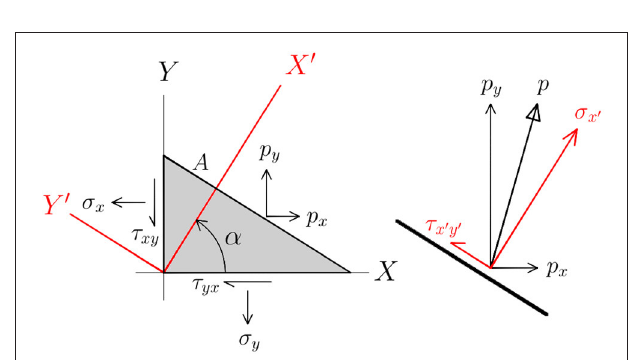
anti-clockwise torque T about the X -axis. In (A) the radial distribution of stress due exclusively to torque is shown along the Y - and Z -axes, in (B) the uniform stress due to the vertical force V is shown along the Y -axis, and in (C) the superposition of those stresses on the Y -axis is shown.